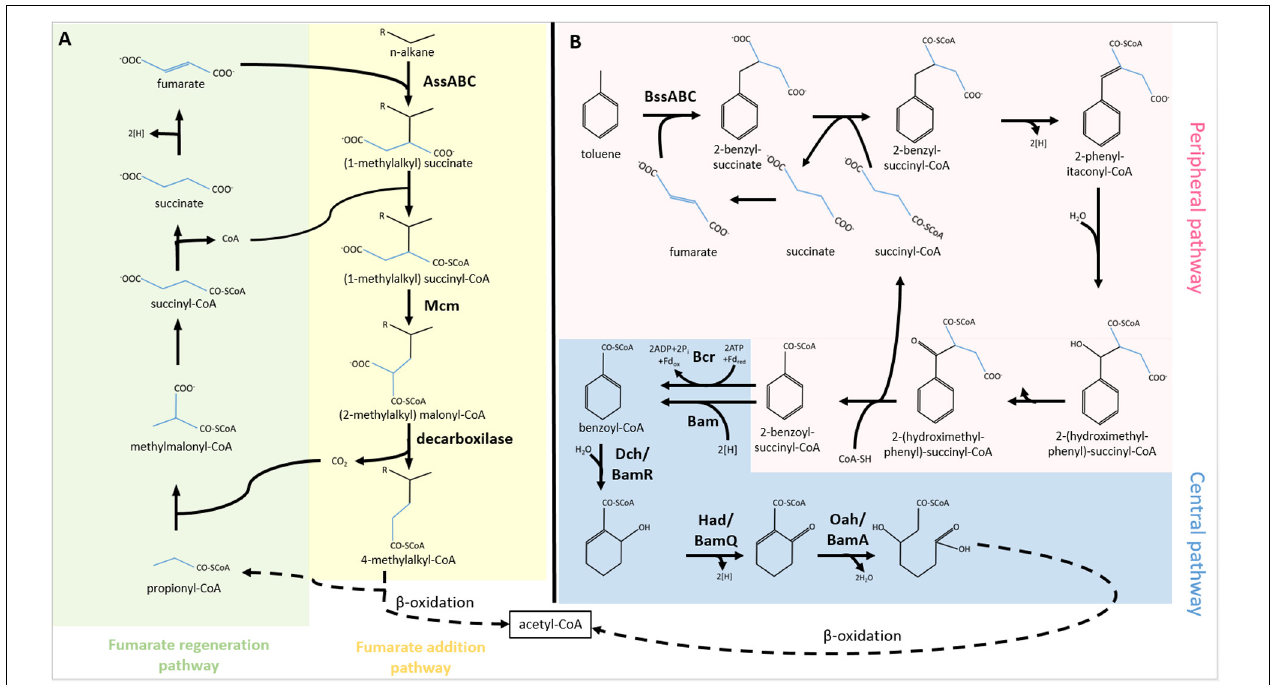
FIGURE 1 | Activation of (A) alkanes and (B) aromatics through fumarate addition and their biodegradation under anaerobic conditions. AssABC, alkylsuccinate synthase; Mcm, methylmalonyl-CoA mutase; BssABC, benzyl-succinate synthase; Bcr/Bam, benzoyl-CoA reductase; Dch/BamR, dienoyl-CoA hydratase; Had/BamQ, hydroxyacyl-CoA dehydrogenase; Oah/BamA, oxoacyl-CoA hydrolase; Fd ox , oxidized ferredoxin; Fd red , reduced